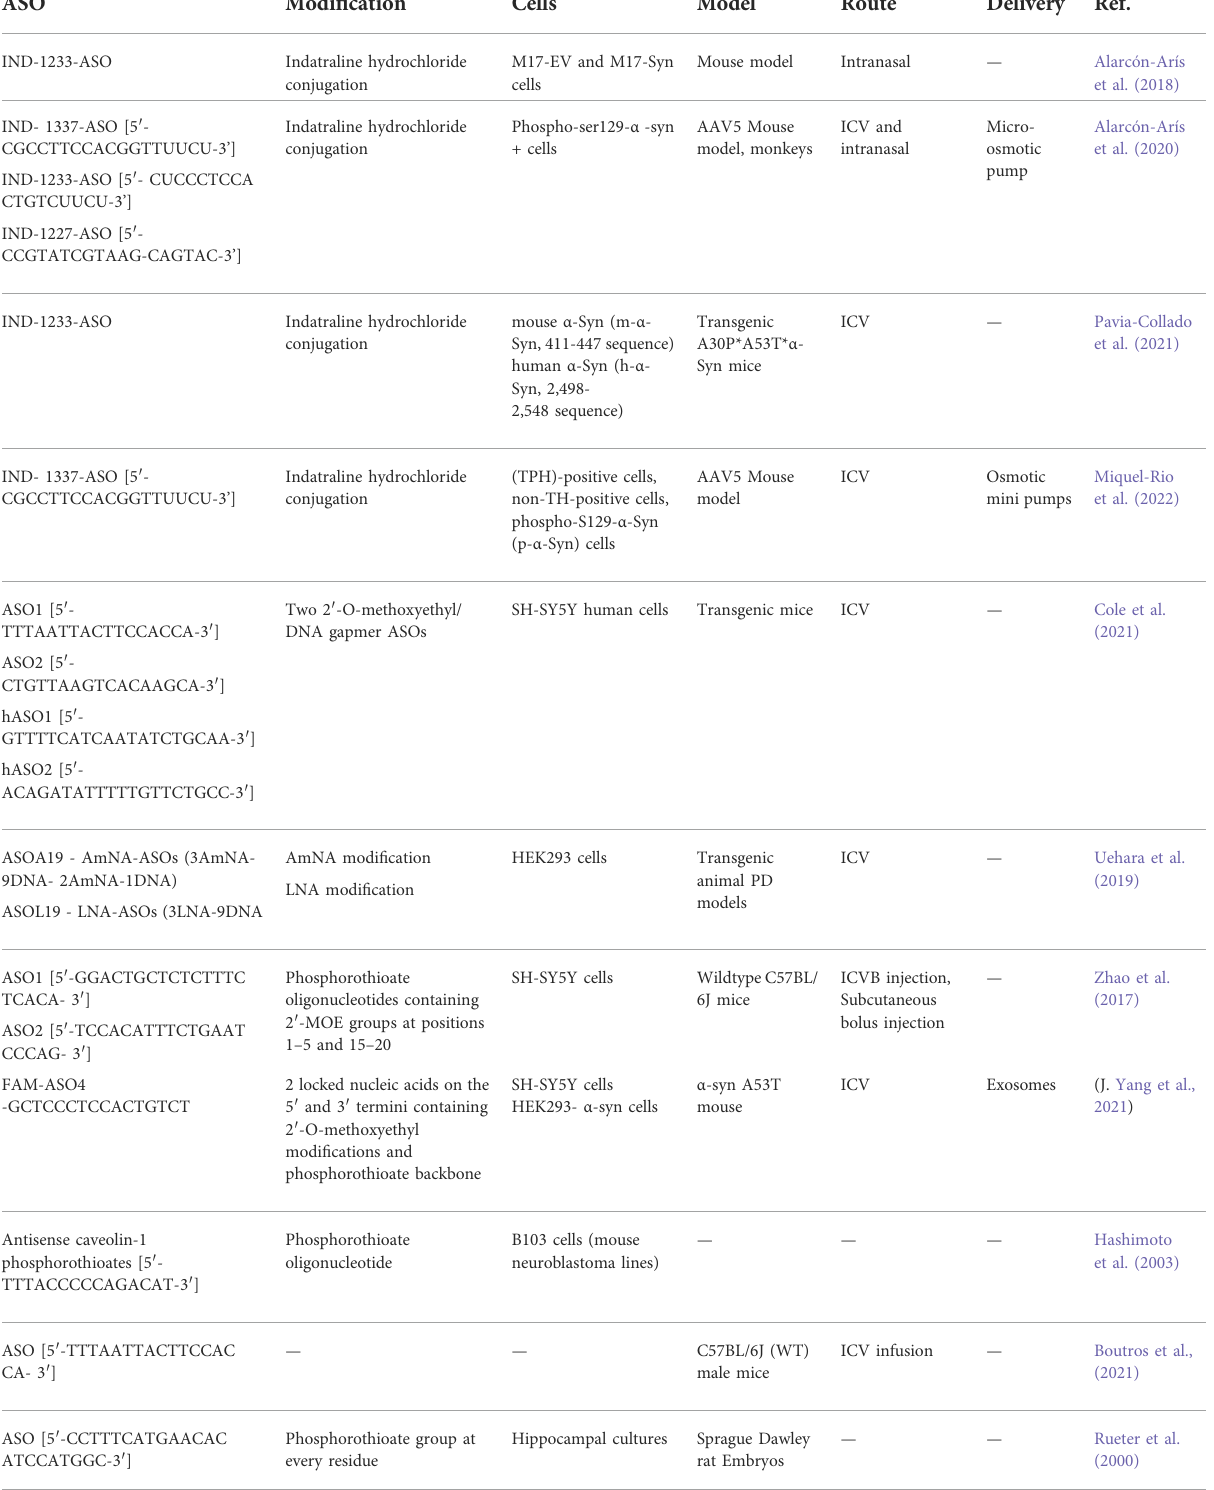
TABLE 2 In vivo studies of